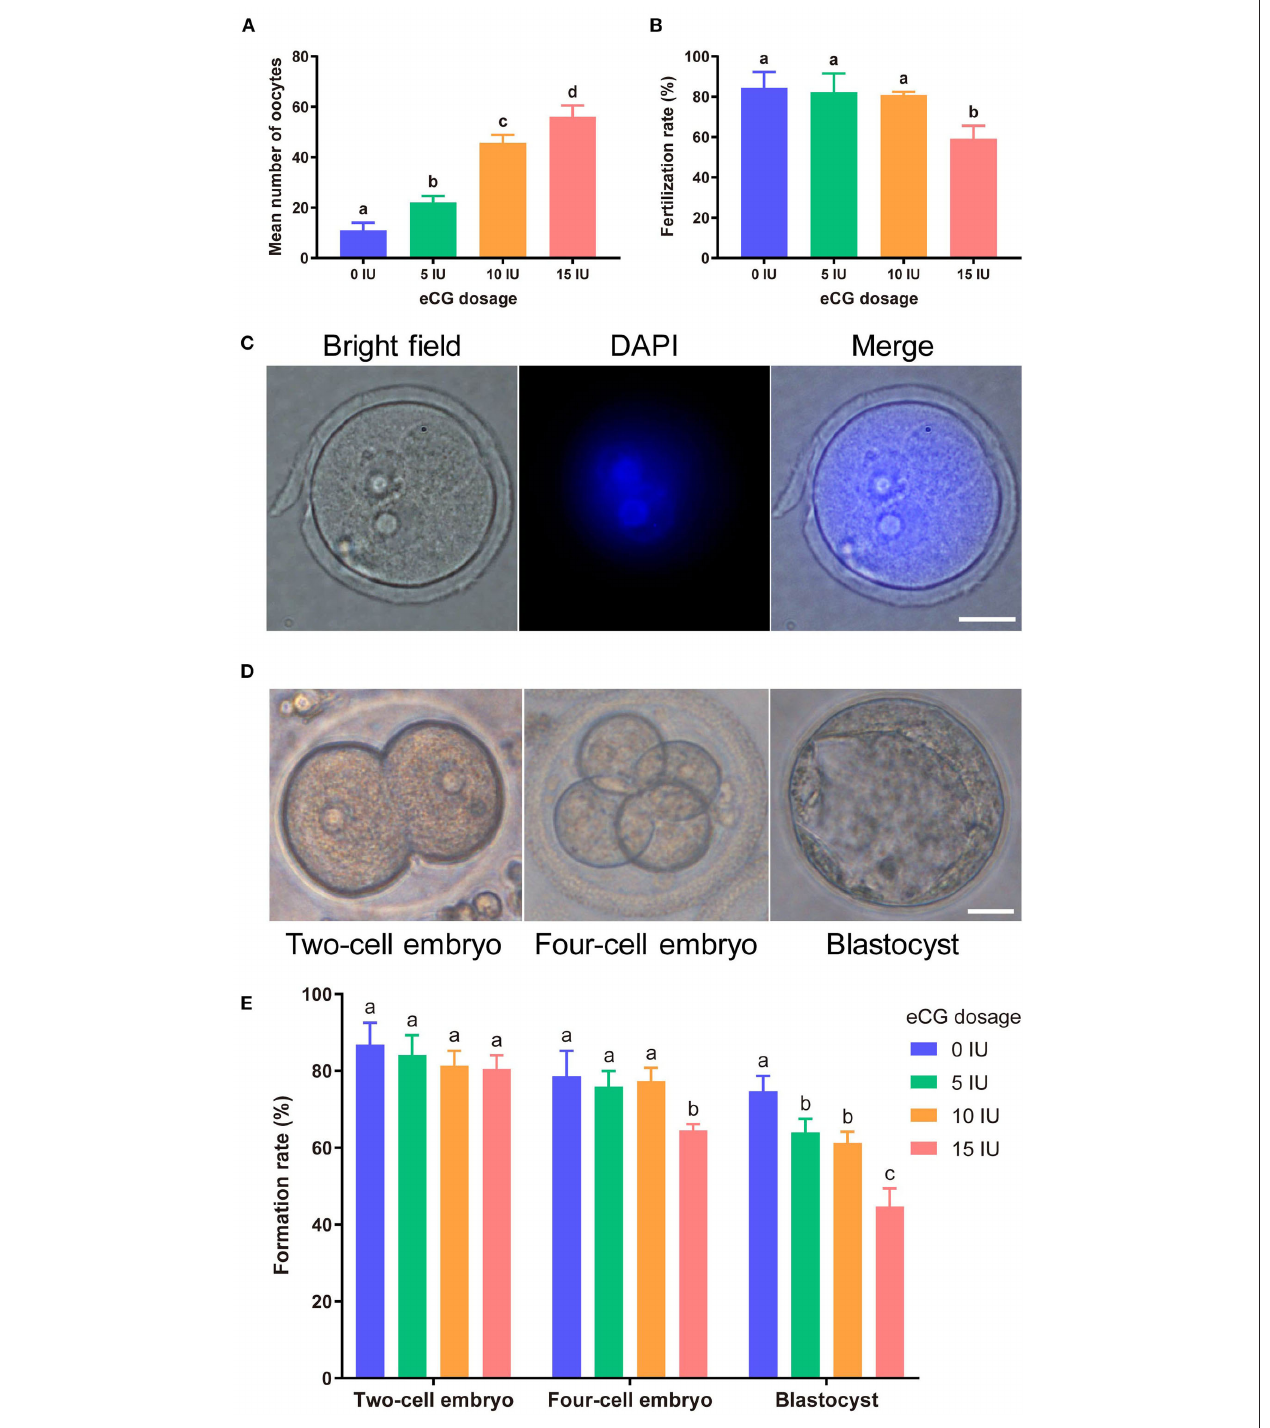
FIGURE 1 | Effects of different eCG doses on the development of IVF-derived mouse embryos. (A) Mean numbers (means ± SD s) of oocytes obtained after administration of 0, 5, 10, and 15 IU eCG (with 10 IU HCG injection). a,b,c,d Bars labeled with different letters are significantly different from each other ( P < 0.05). (B) Fertilization rates after treatments with different eCG doses. a,b Bars labeled with different superscript letters are significantly different from each other ( P < 0.05). (C) Representative images of 2PN zygotes in mouse embryos at 8–10h post insemination (hpi) (scale bar = 20 µ m). (D) Morphological appearances of a two-cell embryo, a four-cell mouse embryo and a single blastocyst. Scale bar = 20 µ m. (E) Rates of two-cell embryo, four-cell embryo and blastocyst formation with different doses of eCG. The data are expressed as the means ± SD s. a,b,c Columns within a group marked with different superscript letters are significantly different from each other, P <